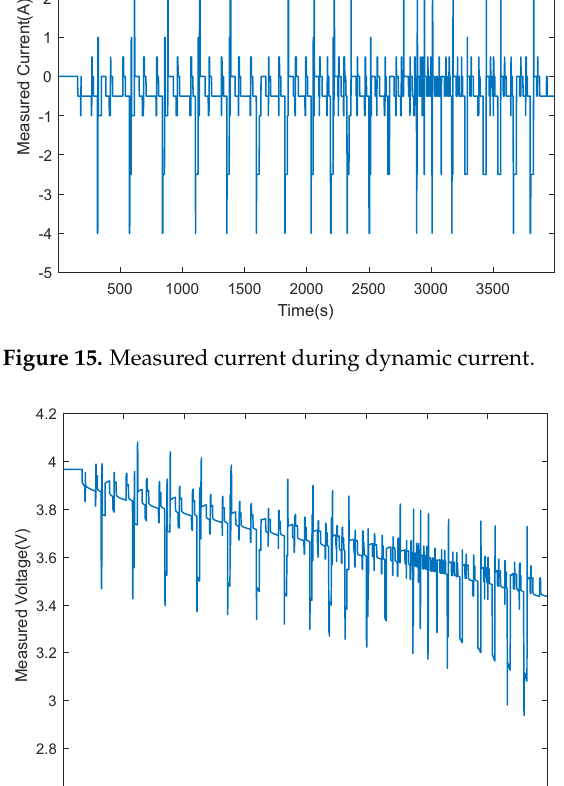
Figure 16. Measured voltage during dynamic current.